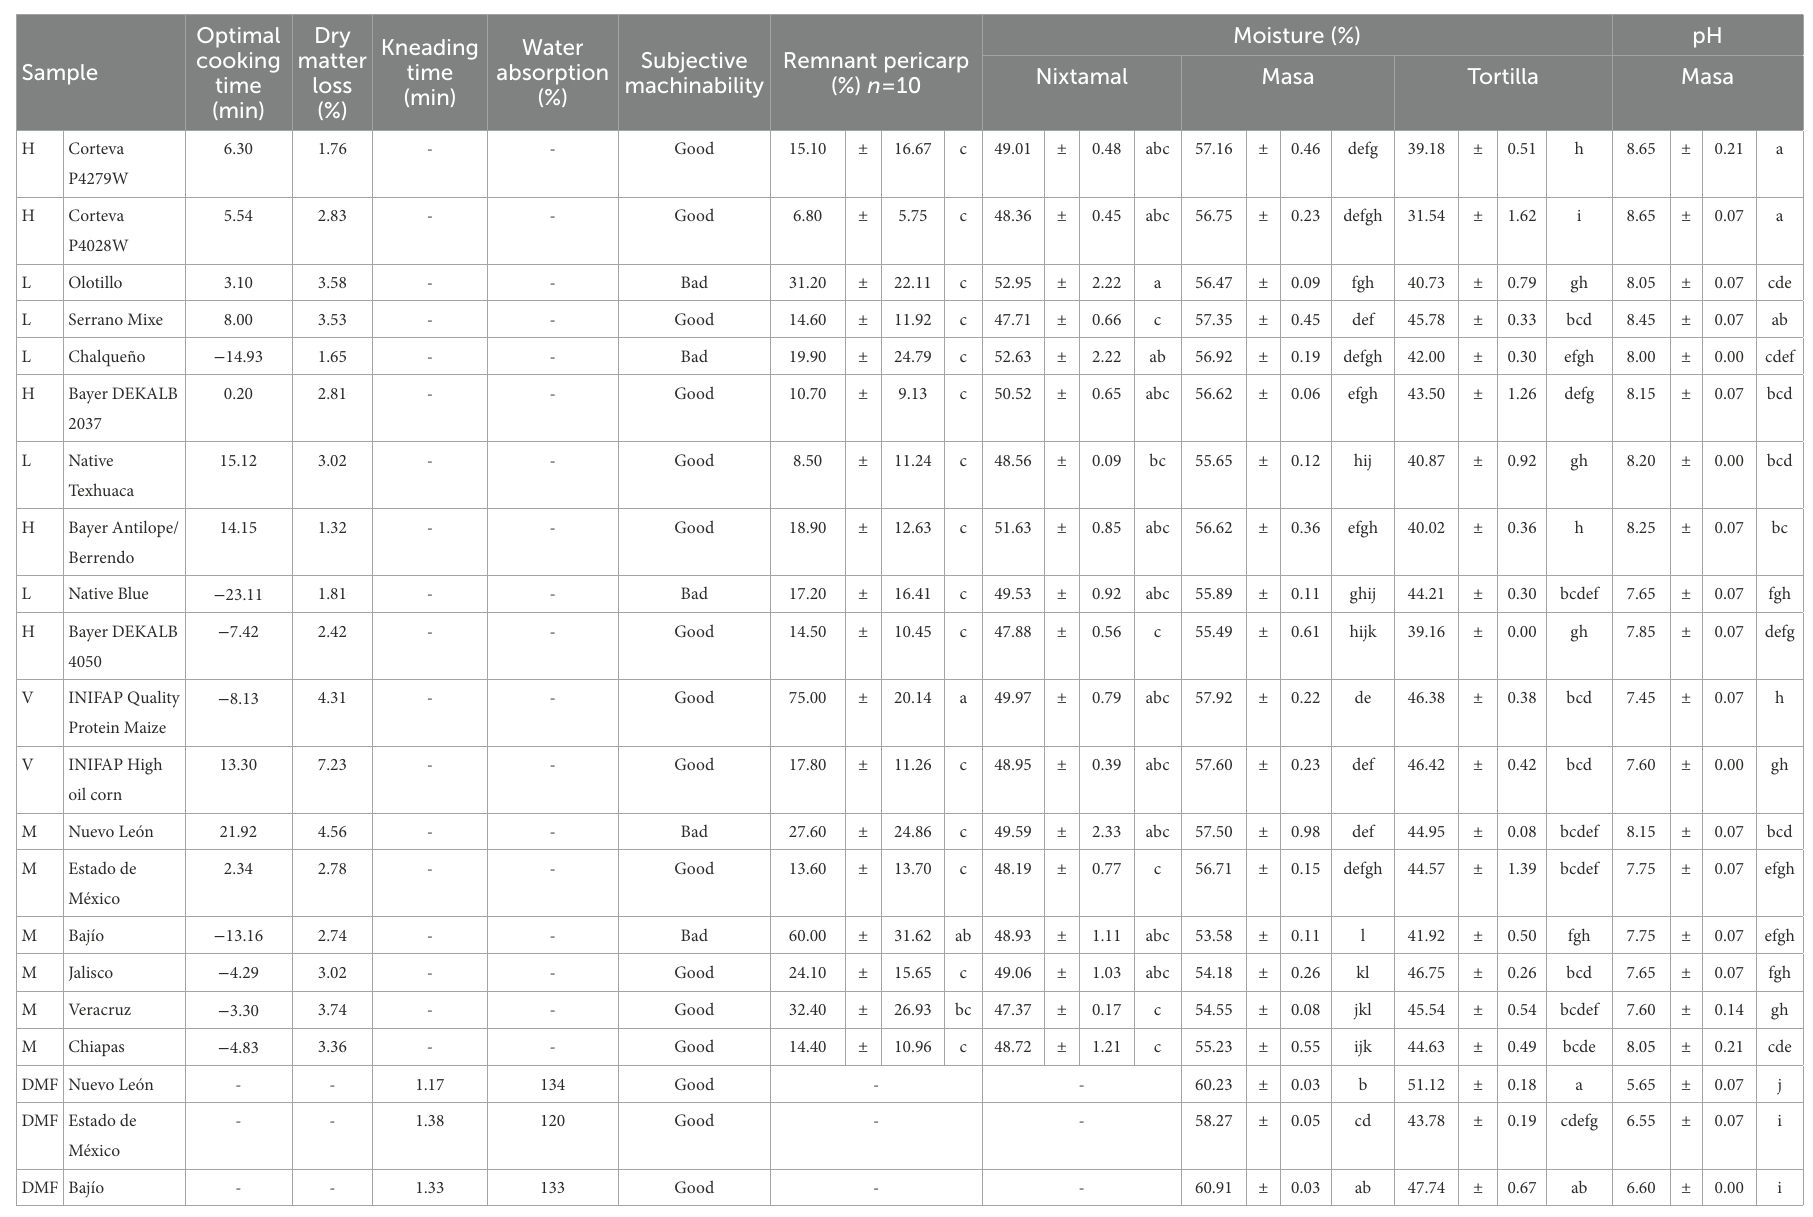
TABLE 2 Transformation of grain to nixtamal, masa and tortilla; process conditions and product characteristics.